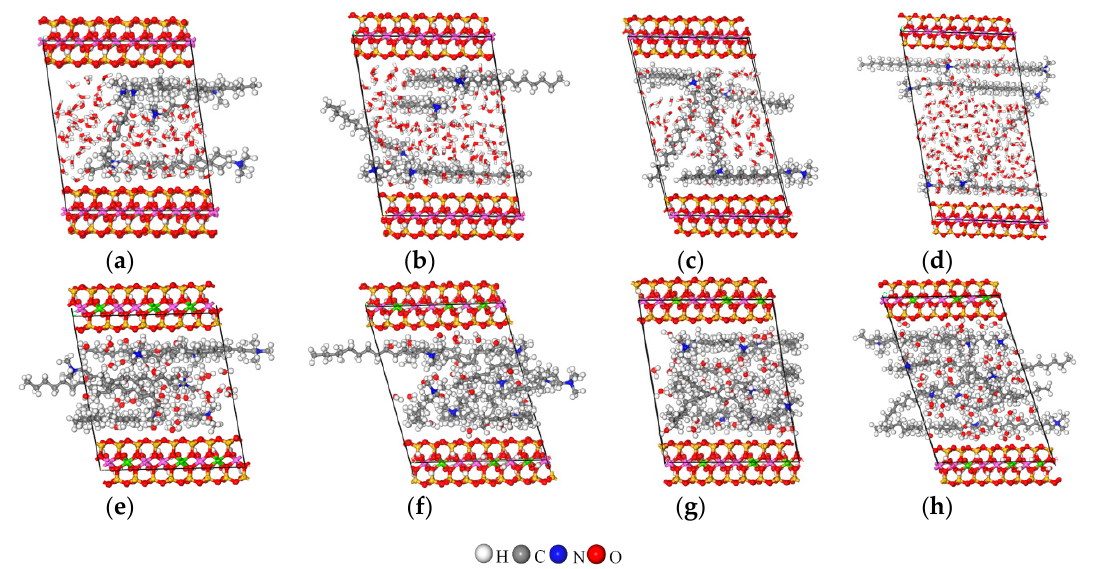
Figure 7. The snapshot of alkyl ammonium cation in organo-MT layers. ( a ) C12-MT1; ( b ) C14-MT1; ( c ) C 16 -MT1; ( d ) C18-MT1; ( e ) C 12 -MT2; ( f ) C 14 -MT2; ( g ) C 16 -MT2; ( h ) C18-MT2.